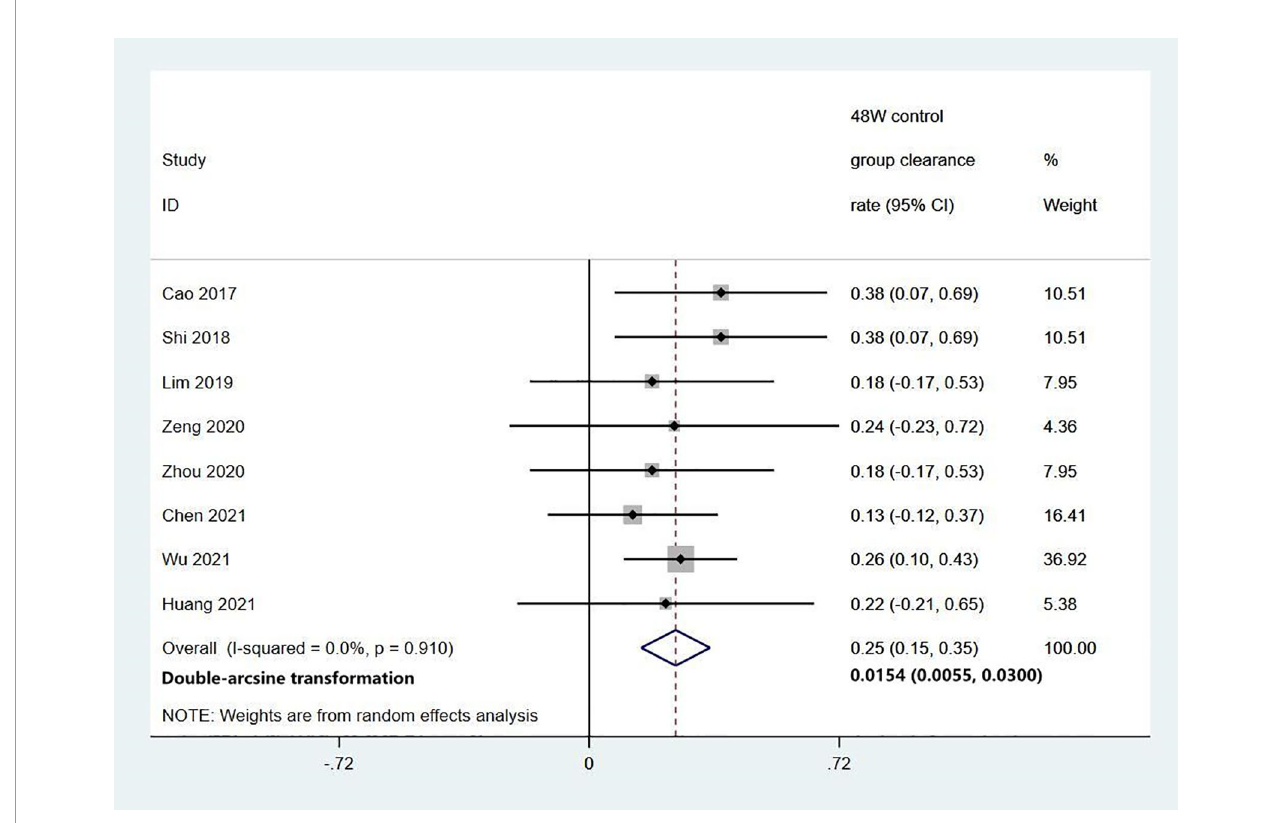
FIGURE 4 | Meta-analysis of the HBsAg clearance rate in the control